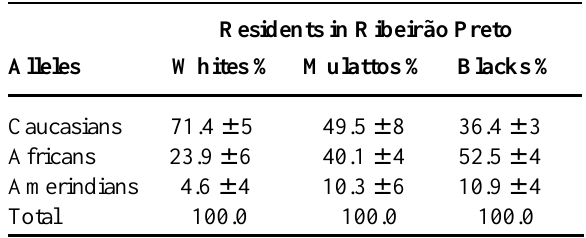
Table 4 – Ethnic admixture in residents from the urban region of Ribeirão Preto classified in Whites, Mulattos and Blacks according to anthropological criteria